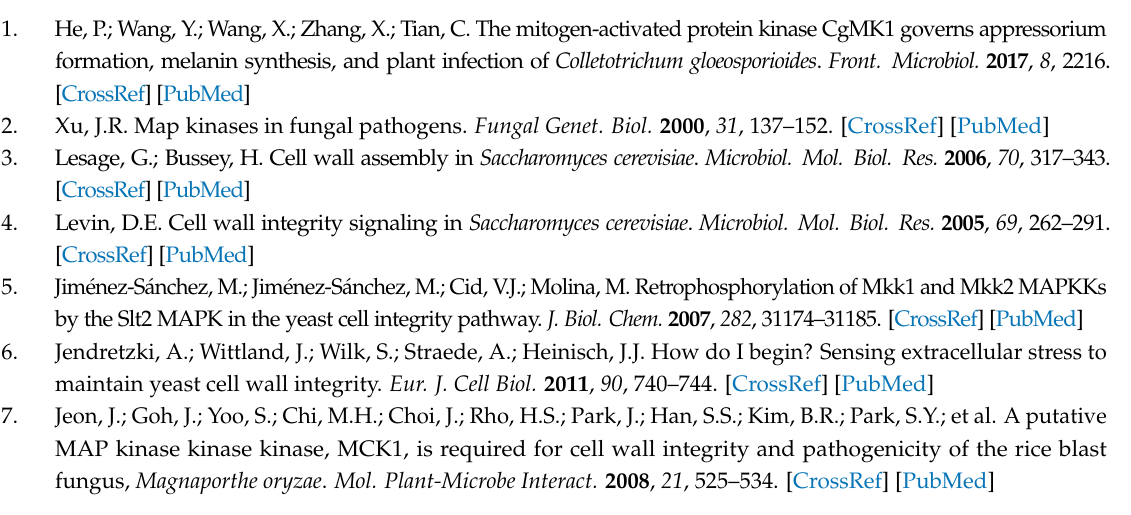
Table S1: Primers used in this